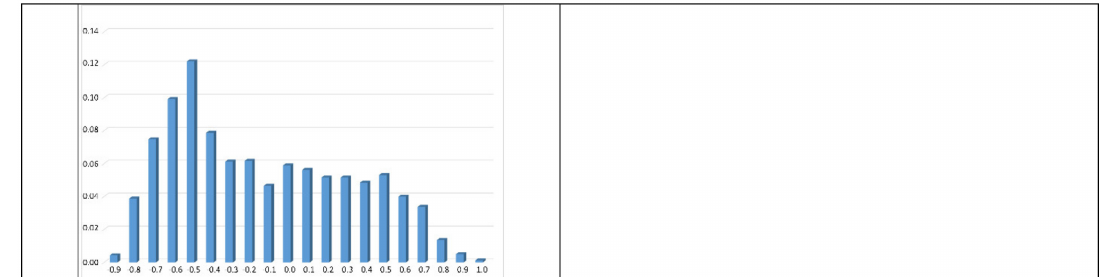
Figure 10. Standardized histograms of the relative frequency distribution of correlation coe ffi cient r values for individual UGSs. The x-axis shows the frequency classes from -1 to 1 in steps of 0.1 for each histogram, and the relative frequency of the occurrence of the correlation coe ffi cient r belonging to each class in the y-axis direction.